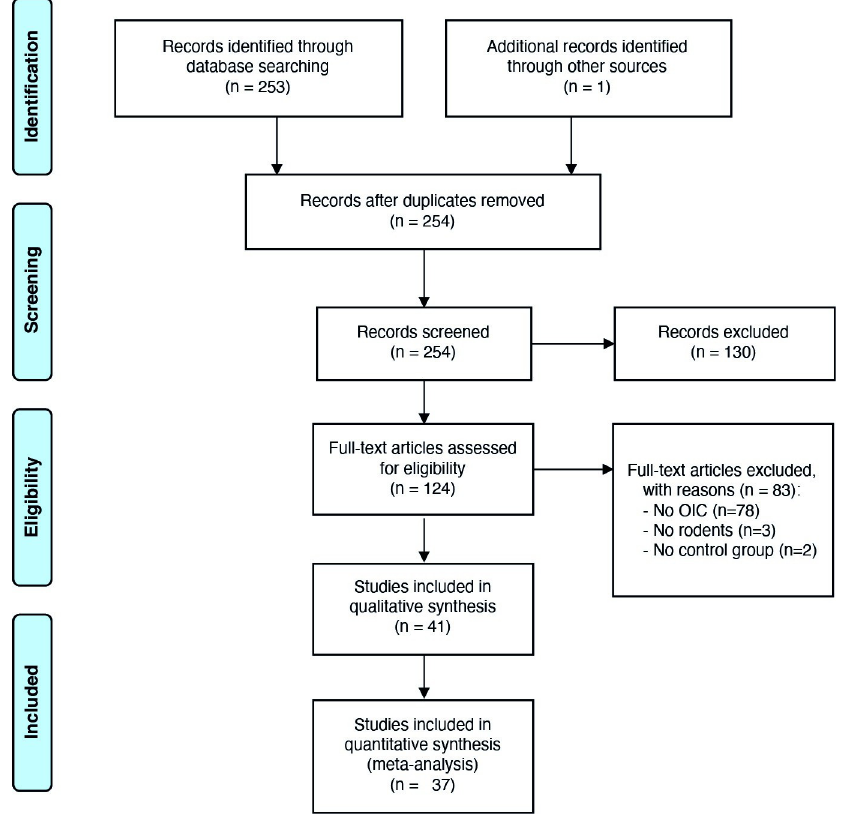
Fig 2. Flowchart of the study.